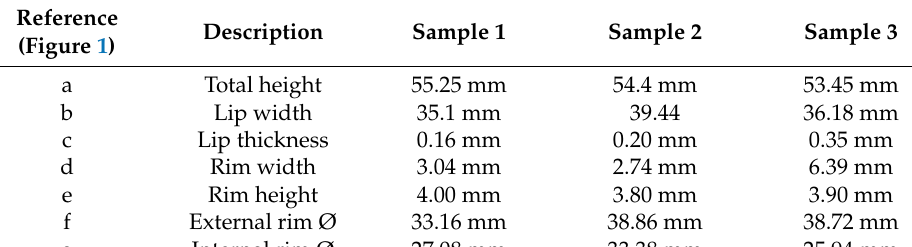
Table 1. Dimensions of the reference waterless trap seals.